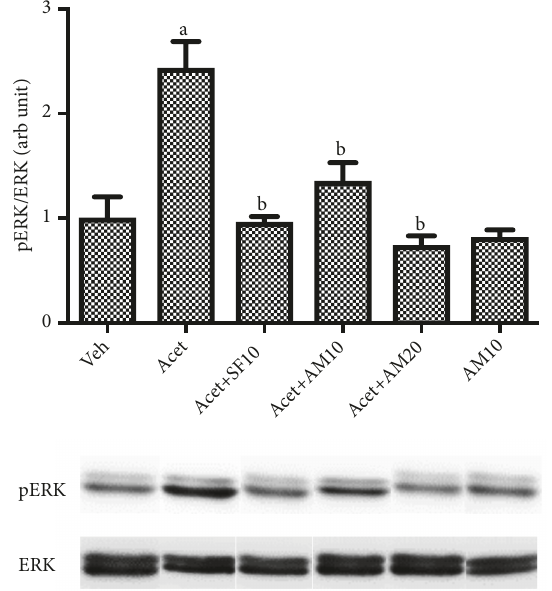
Figure 8: Western blot analysis for pERK/ERK1/2 expressions after LX-2 cells were treated with alpha mangostin with or without acetaldehyde induction. Results were presented as mean ± SEM. a: p < 0.05 versus untreated group, b: p < 0.05 versus acetaldehyde group. Veh: vehicle only, Acet: acetaldehyde 100 𝜇 M, Acet + SF10: acetaldehyde 100 𝜇 M + sorafenib 10 𝜇 M,Acet+ AM10:acetaldehyde